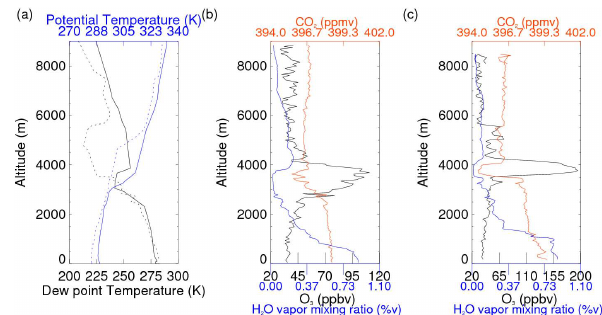
Fig. 8. (a) Potential temperature (blue) and dew point (black) sound- ings at Oakland, CA, on 5 June 2012 at 12:00UTC (dotted lines) and 6 June 2012 at 00:00UTC (solid lines). Mixing ratios of O 3 (black), CO 2 (red) and H 2 O (blue) observed (b) offshore, and (c) over the San Joaquin Valley during descending, vertical profiles on 5 June 2012. Note the change of the O 3 horizontal scale between